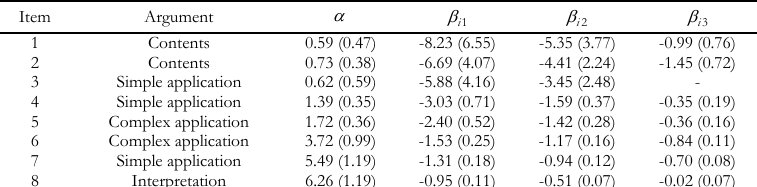
Item parameter estimates for the 3rd test (standard errors in brackets)